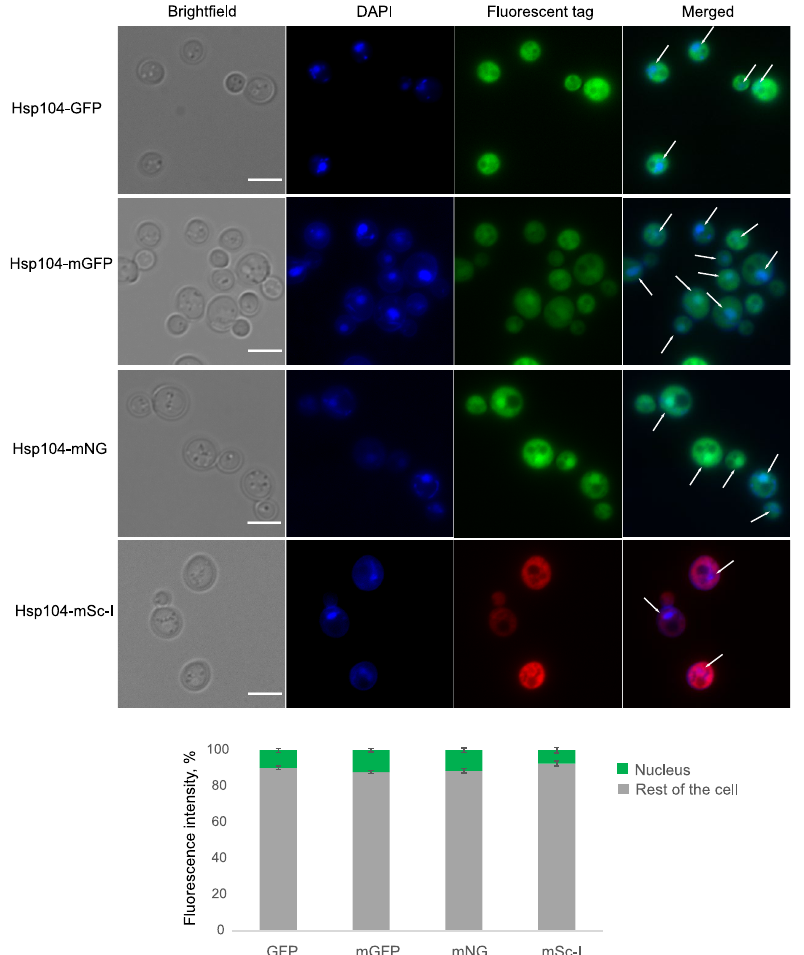
Figure 2. Top: Subcellular localisation of Hsp104 tagged with fluorophores. Live images of overnight grown cells stained with DAPI for nuclear detection. White arrows indicate nuclei within merged images. Scale bar 5 µm. Bottom: Stacked bar chart represents percentage of the total cell fluorescence intensity identified in the nucleus (green) and the rest of the cell (grey). SEM error